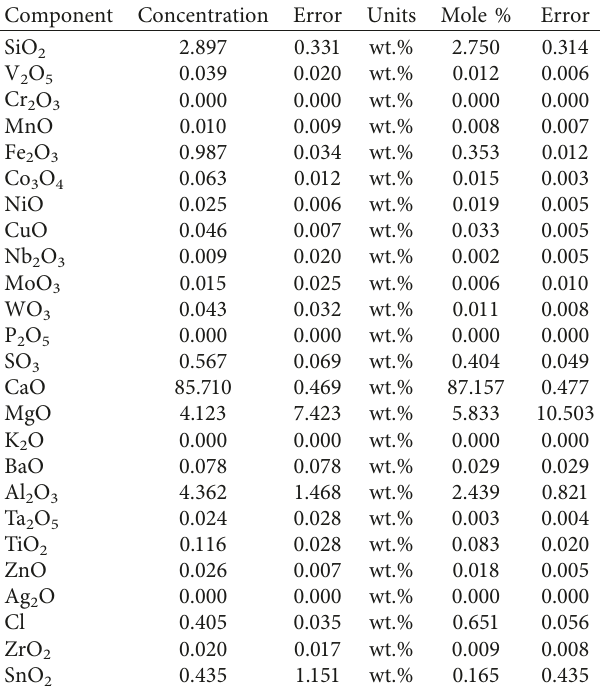
Table 2: XRF result for lime